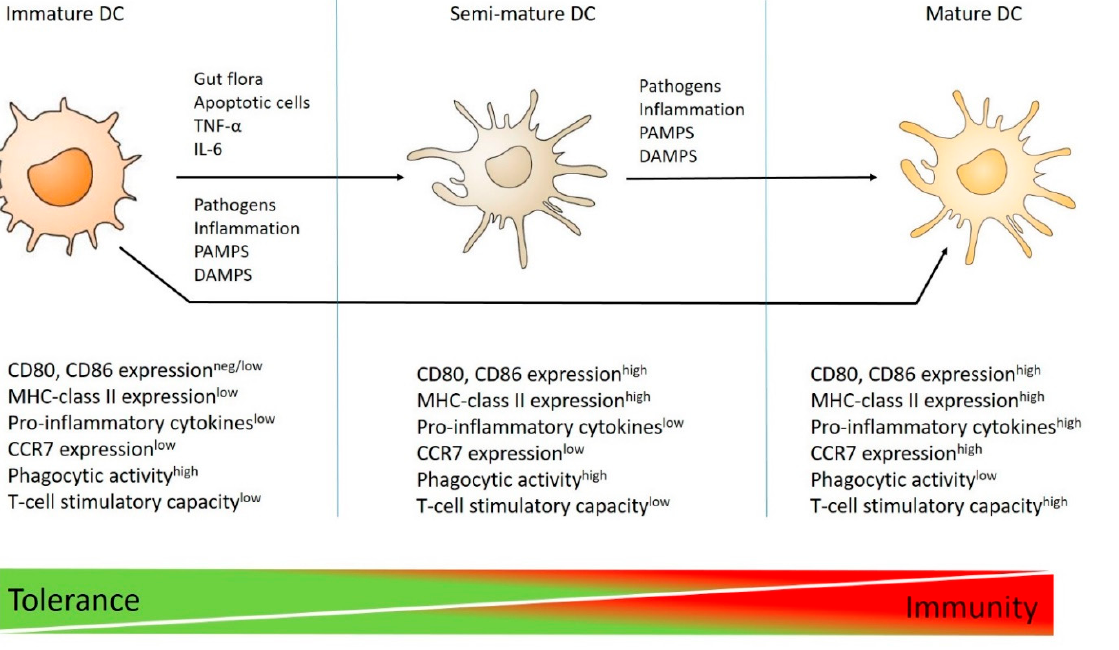
Figure 2. The classical scheme of different dendritic cell states in T cell tolerance and immunity. Dendritic cells (DCs) in the steady-state, i.e., in the absence of microbial or inflammatory signals, are immature and can internalize exogenous antigens and process them for MHC class-II-mediated presentation. However, they are devoid of strong upregulation of costimulatory molecules (CD80, CD86), MHC-class II, and proinflammatory cytokines; therefore, they cannot prime immune re- sponses. Partial maturation results in elevated levels of costimulatory molecules and MHC-class II, but a lack or reduced level of proinflammatory cytokines gives rise to a DC population called semi-mature DCs. This population of DCs can be induced by lactobacilli from the gut flora, apoptotic cells, IL-6, or TNF- α . Both immature and semimature DCs prompt T-cell immune tolerance. Full DC maturation can be induced by extraneous factors, such as microbial or inflammatory signals, leading to downregulation of antigen acquisition and the antigen-processing ability, increased expression of CD80, CD86, and MHC-class II, and elevated levels of proinflammatory cytokines. All of these events result in T-cell priming and an increase in immunogenicity. TNF- α , tumor necrosis factor-alpha; IL-6, interleukin-6; MHC, major histocompatibility complex; PAMPS, pathogen-associated molecular patterns; DAMPS, damage-associated molecular patterns; CCR7, C-C chemokine receptor type